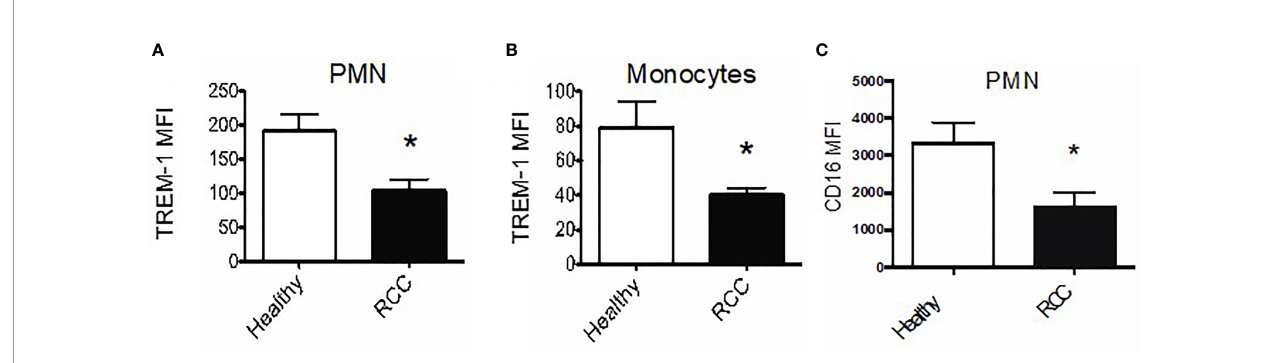
FIGURE 6 | TREM-1+ myeloid cells in fi ltrate human renal tumors. (A) Average TREM-1 mean fl uorescence intensity on peripheral blood polymorphonuclear neutrophils (PMN) and monocytes (B) from healthy (n = 3) vs. RCC donors (n = 5). (C) CD16 expression on peripheral blood PMN from healthy vs. RCC donors; *pvalue